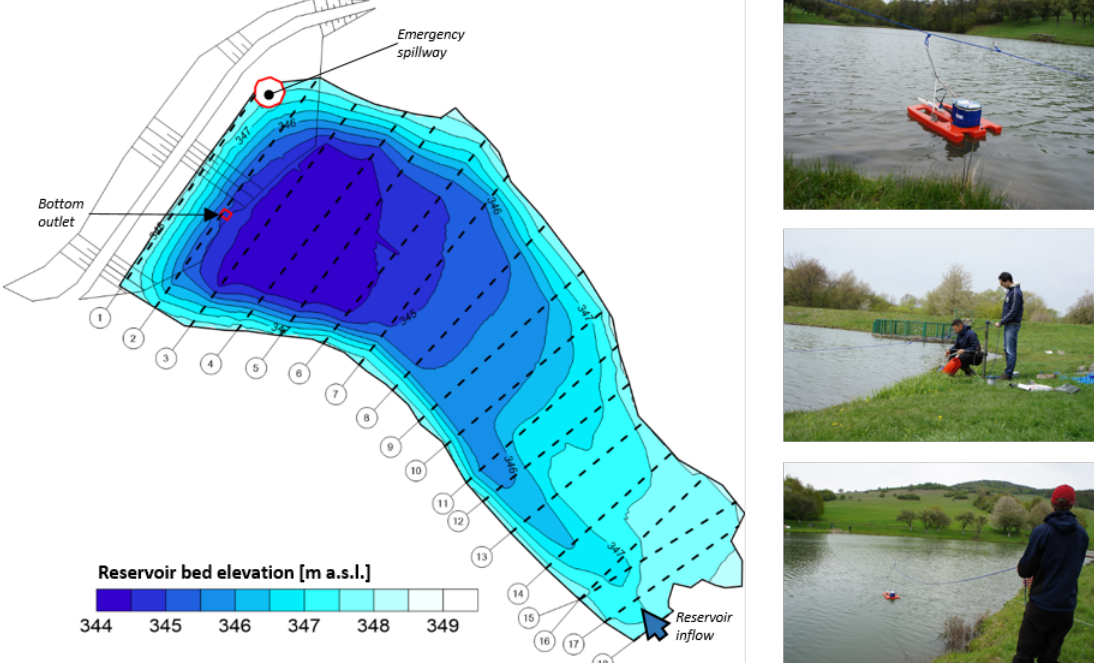
Figure 4. Left : Position of the 18 transects delineating the path of the acoustic Doppler current profiler (ADCP) measurements. Two measurements were carried out within each transect. Right : The 2017 bathymetry survey was based on towing the ADCP from one bank of the reservoir to